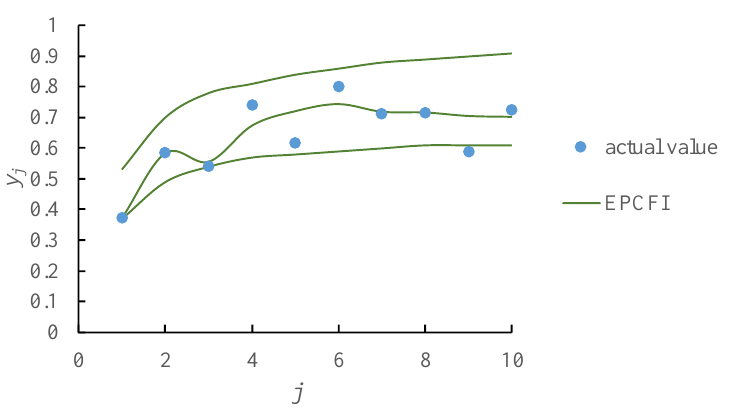
Figure 10. Defuzzification results.